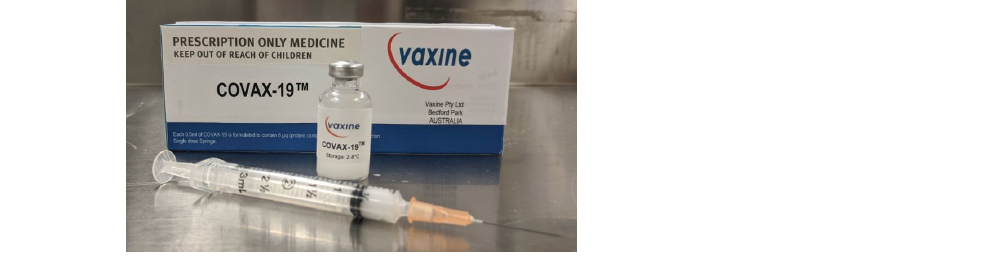
Figure 6. Covax-19™ is an Australian-designed COVID-19 vaccine modeled by AI-based technolo- gies